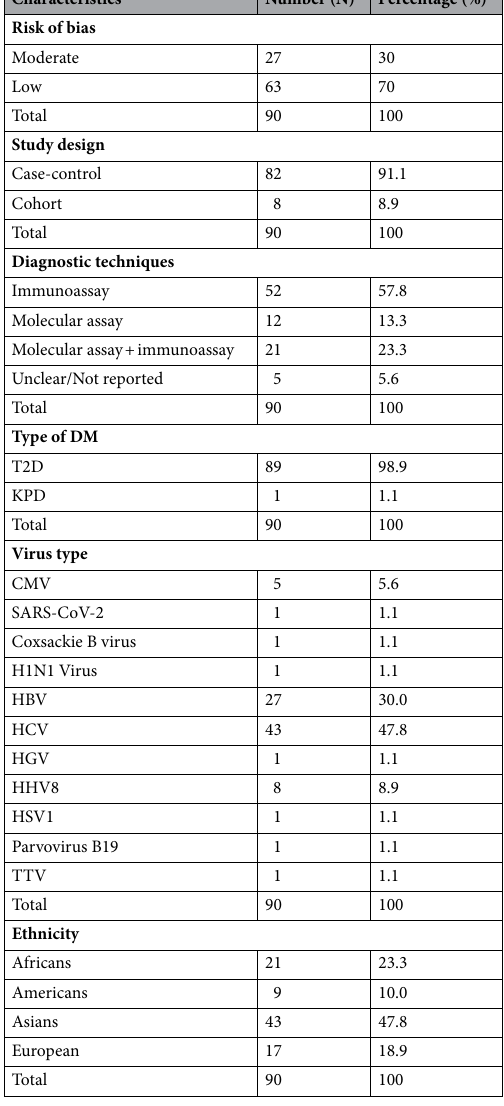
(Fig. 4D) and HGV (summary OR: 0.2 95% CI: 0–6.2) (Fig. 4E) infections to be non-statistically significant compared to healthy individuals without non-autoimmune diabetes. For CMV infection, the funnel plot did not suggest publication bias (S5 Fig.), and this result was confirmed by the Egger test. The OR in studies with low risk of bias (summary OR = 6.495% CI: 0.5–77.7) was different from the overall OR and substantial heterogeneity was present overall and within all subgroups (Table 2). Subgroup analysis. With respect to ethnicity, the risk of HCV, HHV8 and HBV infection in individuals with non-autoimmune diabetes was higher in the European population than in other ethnic groups. Accord- ing to type of non-autoimmune diabetes, the HHV8 infection risk was higher in KPD individuals (summary OR = 10.7 [95% CI: 4.9–23.3]) compared to T2D individuals (summary OR = 2.2 [95% CI: 1.1—4.5]; I 2 = 90%). For diagnostic techniques used to detect virus infection, the risk of CMV and HCV infection in individuals with non-autoimmune diabetes was statistically different according to diagnostic techniques (immunoassay alone, molecular assay alone or molecular assay and immunoassay) (S4